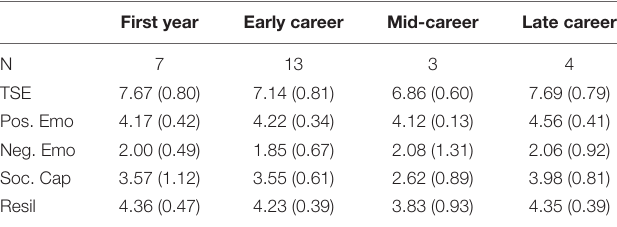
Standard deviations are presented in parentheses. TSE, Teacher Self-Efficacy; Pos. Emo, Positive Emotions; Neg. Emo, Negative Emotions; Soc. Cap, Social Capital; and Resil,